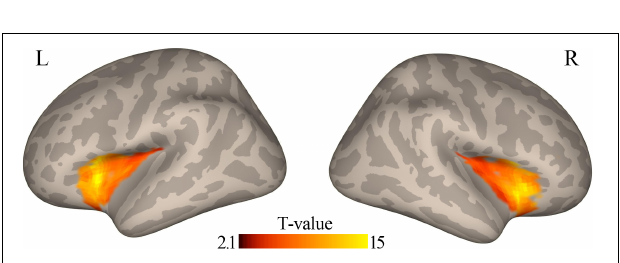
FIGURE 2 | Positive functional connectivity between the left DLPFC and bilateral insular cortex was observed using a one-sample t -test ( p < 0.05). DLPFC, dorsal lateral prefrontal